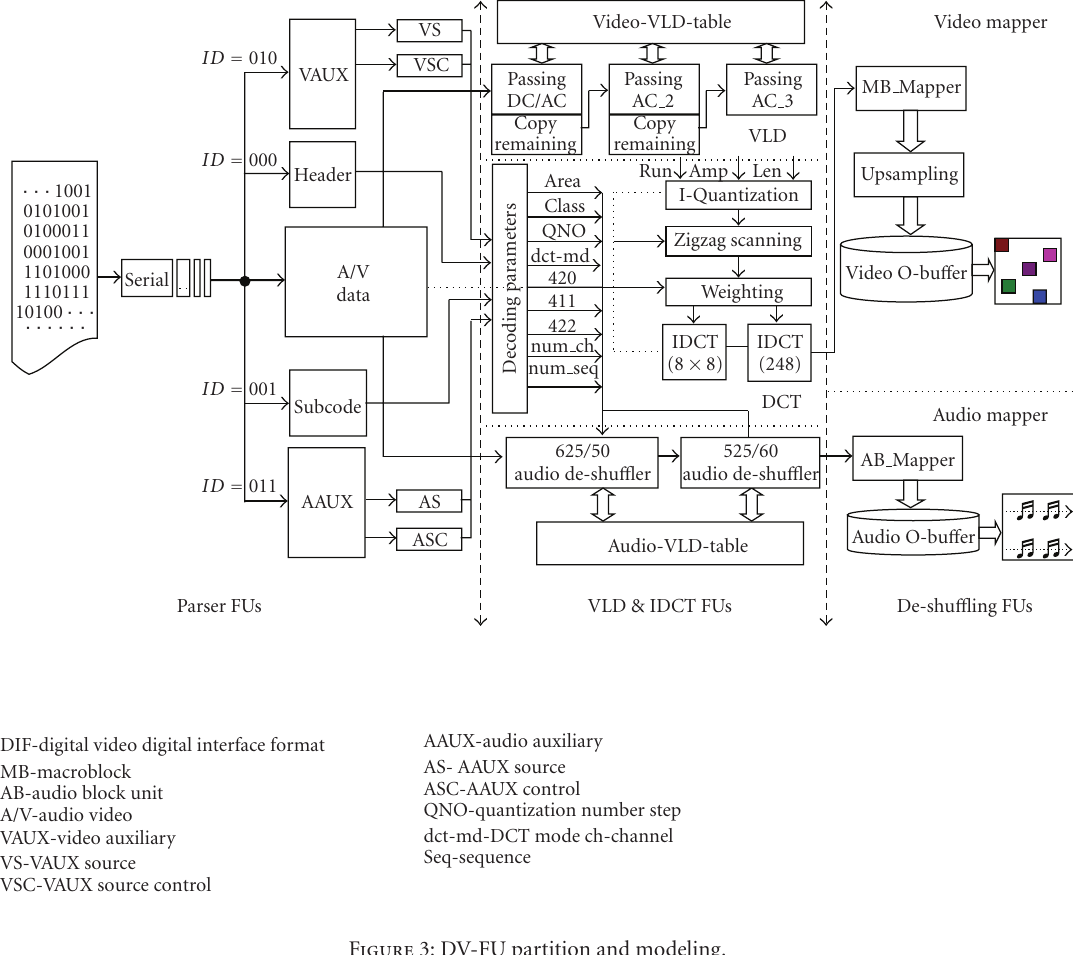
Figure 3: DV-FU partition and modeling.